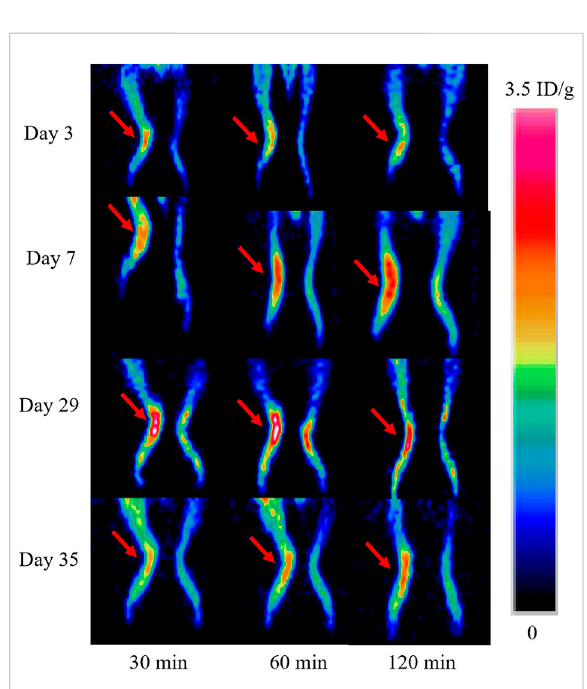
FIGURE 7 18 F-VUIIS1008 PET imaging of RA rat model at 30, 60, and 120 min post-injection on day 3, 7, 29, 35 after CFA injection. Red arrow indicate left in fl ammatory